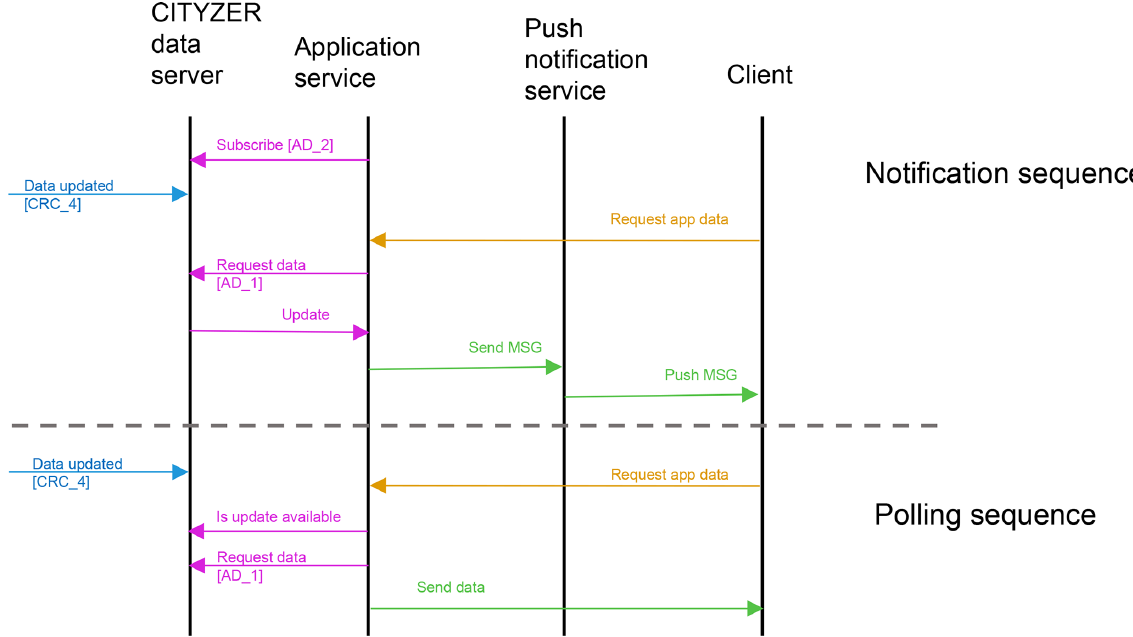
Figure 5. CITYZER user application access